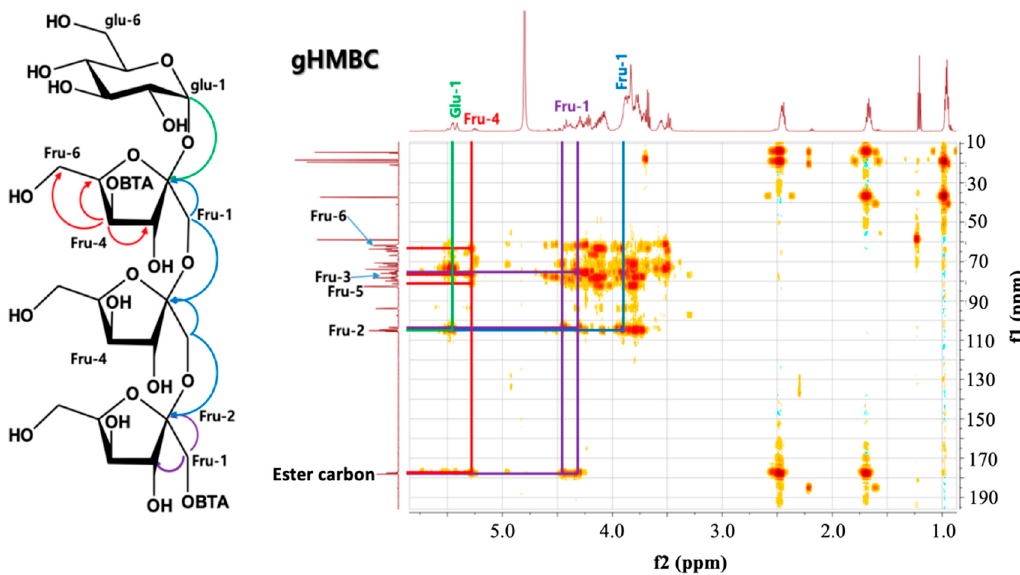
Figure 3. Two-dimensional nuclear magnetic resonance (2D-NMR) HMBC (heteronuclear multiple bond correlation) spectrum of B-FOS. The arrows indicate key correlations of B-FOS in the gHMBC spectrum. BTA denotes butyrate.